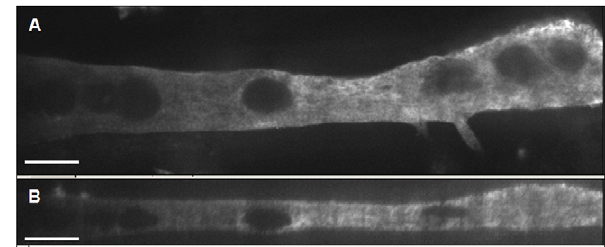
Figure 3. Confocal micrographs of cultured myotubes on cantilevers (cantilever not visible). A) Top down view of a single myotube stained for myosin heavy chain. B) Side view of a three dimensional image reconstructed from a stack of confocal sections. Scale bars are 20 m m.